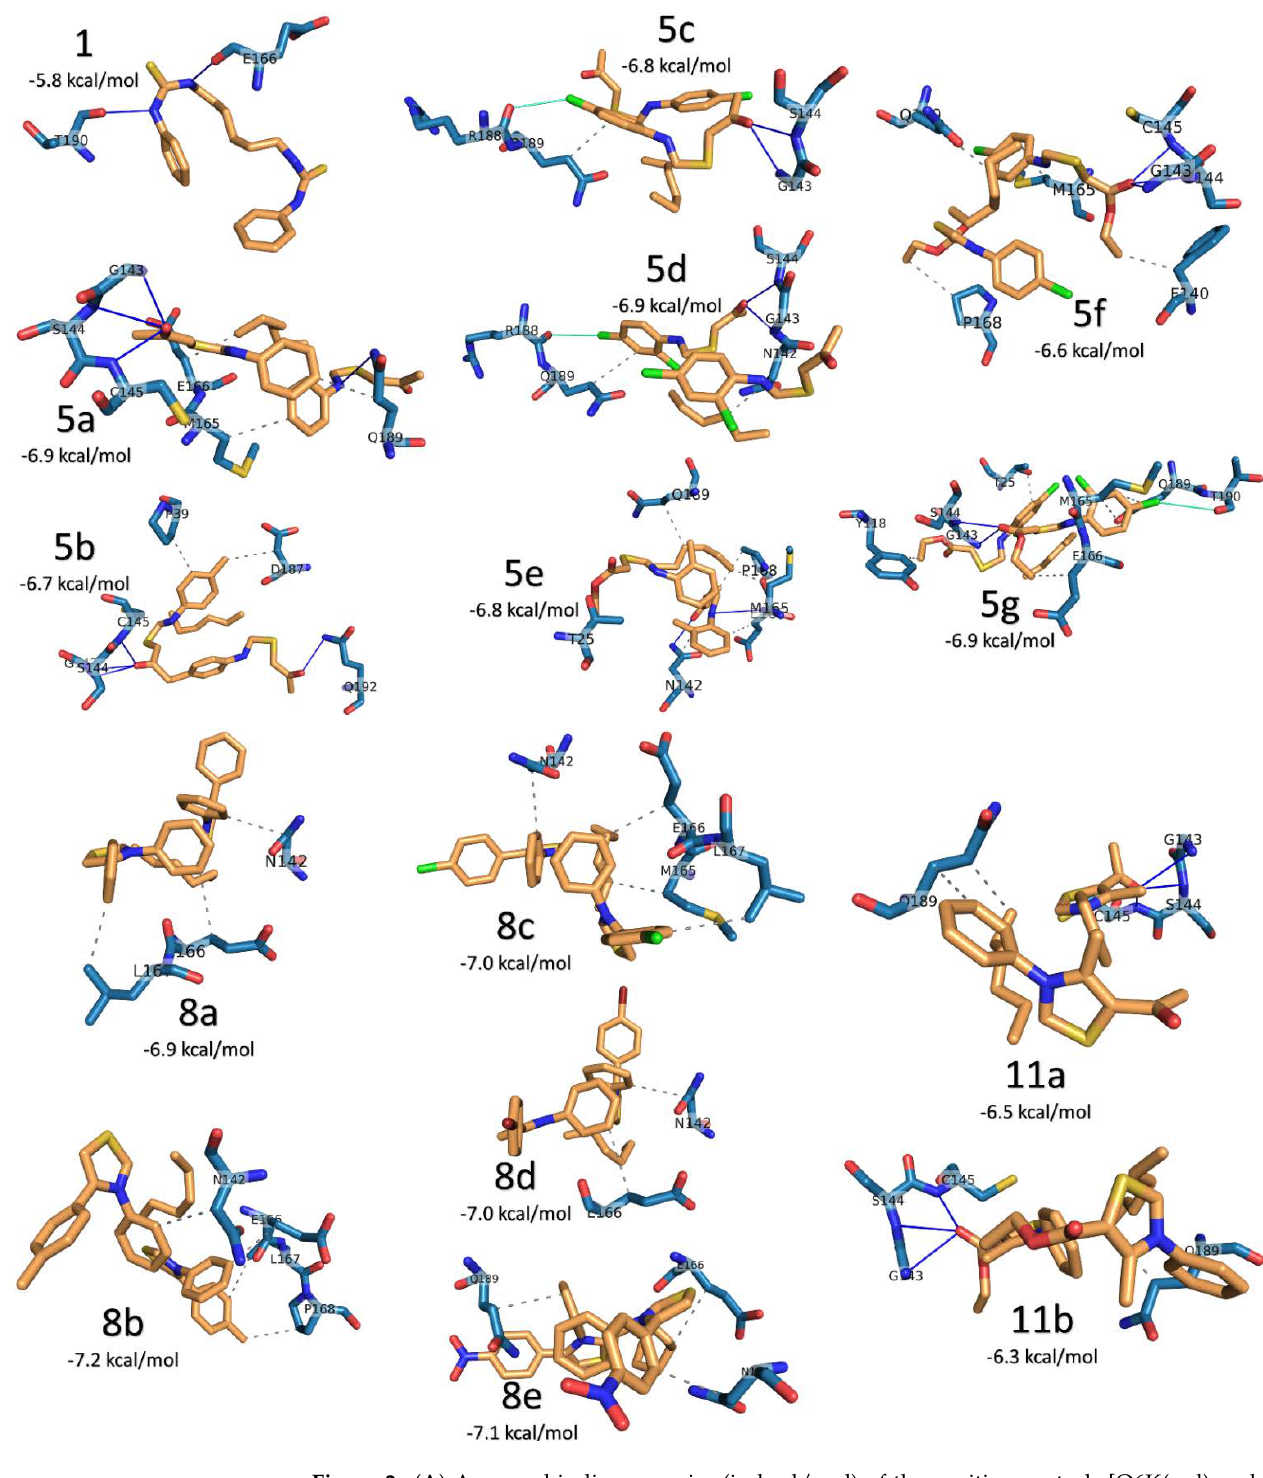
Figure 2. ( A ) Average binding energies (in kcal/mol) of the positive controls [O6K(red) and N3 (orange)] and compounds 1 , 5a-h , 8a-e , and 11a,b (blue) docked into the active site residues of SARS-CoV-2 M pro . Error bars represent the standard deviations. The best compound in binding the SARS-CoV-2 M pro ( 5h ) is shown in green. ( B ) The docking complexes of compounds against SARS-CoV-2 M pro are depicted by PyMOL software.